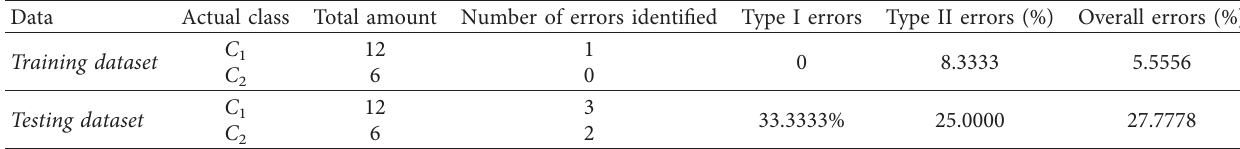
Table 10: Error summary with SM-logistic regression